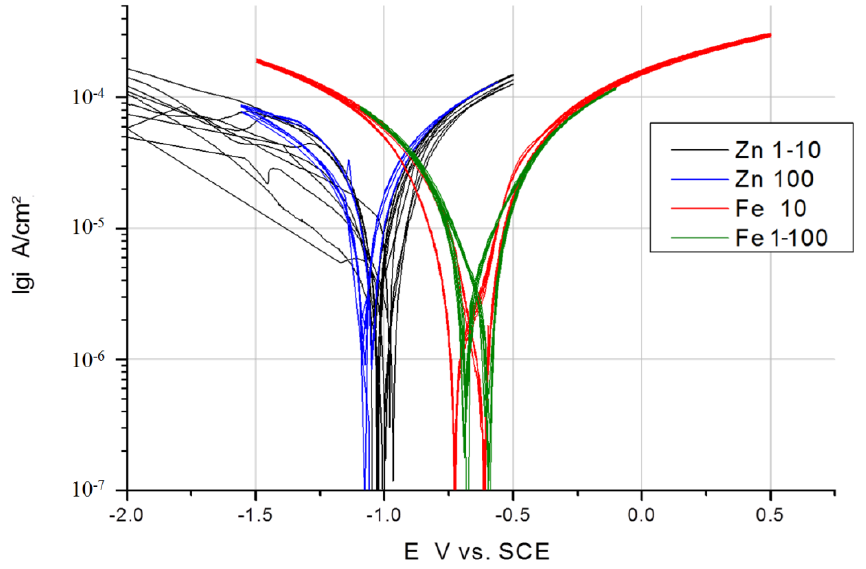
= −1.004 V vs. SCE; E = −0.685 V vs. Zn Fe